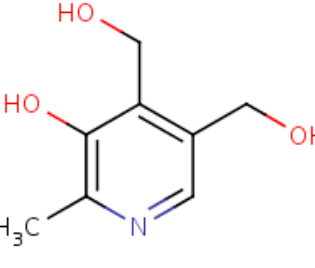
Figure 11. Pyridoxine structure.